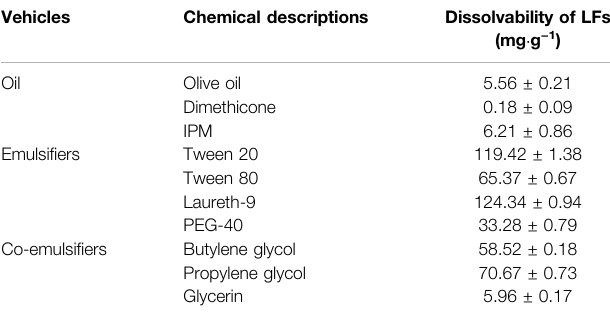
TABLE 3 | Dissolvability of LFs in different vehicles. Data are mean ± SD (n (cid:2) 3).